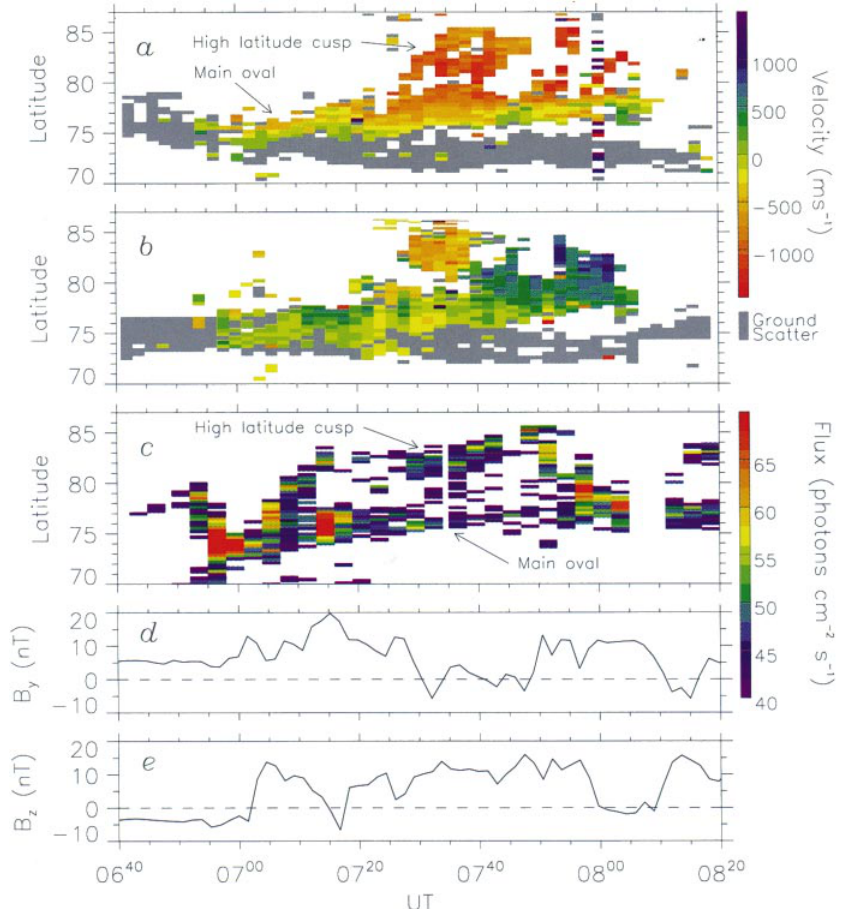
Fig. 4. a , b Latitude-time-velocity plots from beams 5 and 9 of the CUTLASS Finland HF coherent radar. c Latitude- time-photon flux plot from the 14 MLT meridian of Polar UVI images taken with the LBHs filter. d , e IMF B and B y z components measured by the Wind MFI instrument, lagged by 21 min to account for the propagation delay in the